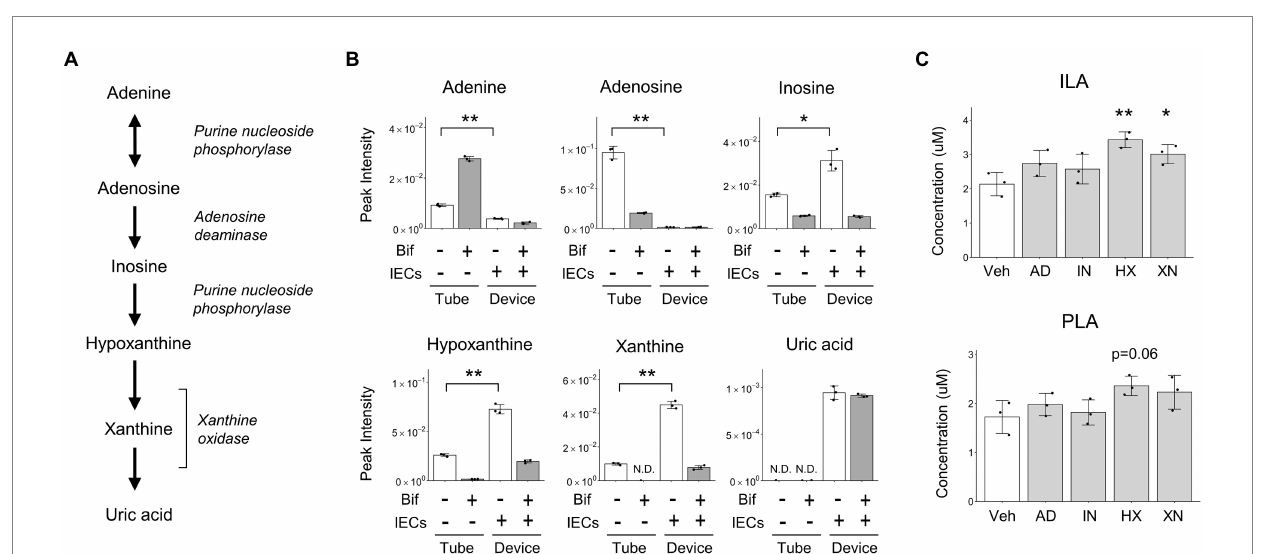
FIGURE 5 B. breve MCC1274 purine metabolism. (A) The purine metabolism pathway from adenine to uric acid. (B) Peak intensity of purine metabolites detected using CE-FTMS, * p < 0.05, ** p < 0.01 (Welch’s t -test). (C) Aromatic lactic acid concentrations when cultured in the YC medium with purines. * p < 0.05, ** p < 0.01 (Dunnett’s test). Data are expressed as the mean ± SD ( n = 3). AD, Adenosine; HX, Hypoxanthine; IN, Inosine; Veh, vehicle; XN,